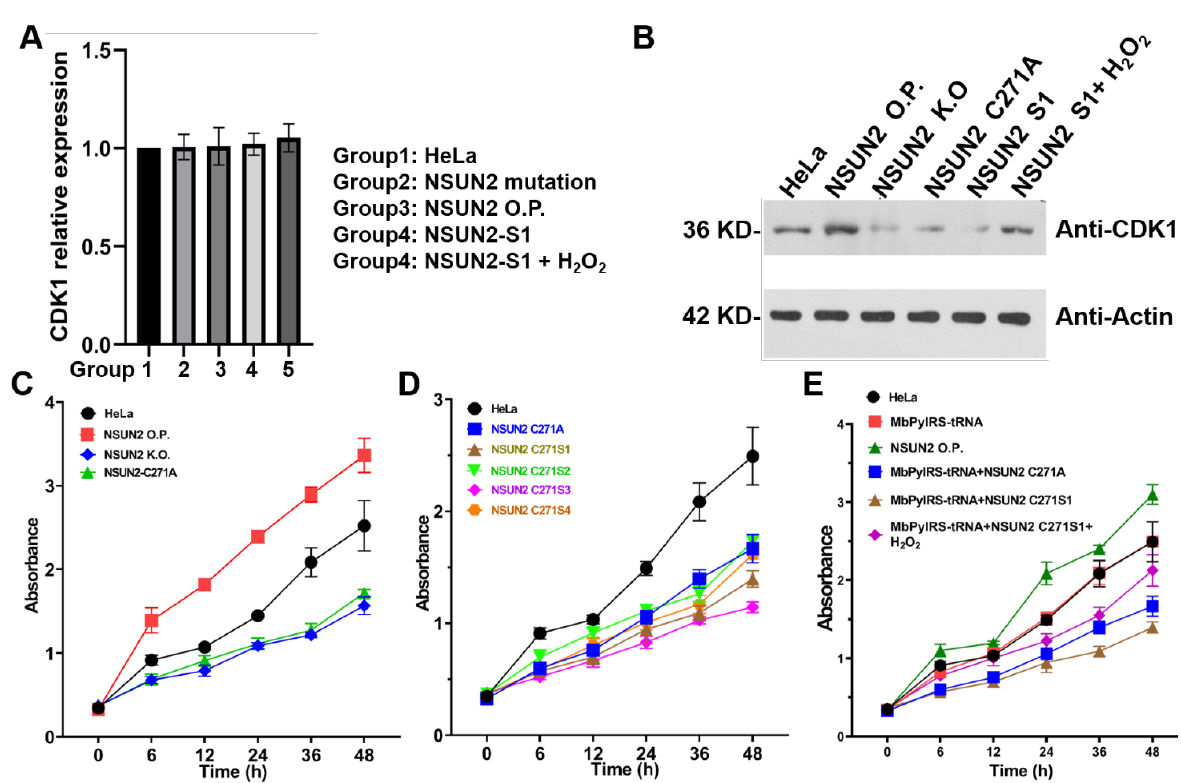
Figure 4. Investigations of NSUN2 mutants towards cells activities. ( A ) Detection of the effect of NSUN2 overexpression, knockout, and C271 mutated to S1 and C271S1 restored to natural lysine on downstream gene CDK1 in HeLa cells via RT-PCR agarose gel electrophoresis. The experimental results show that NSUN2 has no significant effect on the transcription level of CDK1 . ( B ) Detection of the effect of NSUN2 overexpression, knockout, C271 mutated to S1 and C271S1 restored to natural lysine on downstream gene CDK1 in HeLa cells via Western blotting assays. ( C ) The effect of NSUN2 C271A mutation and C271 mutated with S1–S4 on cell proliferation activities, CCK8 was used to detect cell proliferation. The mutation of C271 site significantly inhibited the activity of NSUN2 , and NSUN2 C271 mutated with S3 (pink color) displayed the highest inhibition activity. ( D ) The effect of NSUN2 overexpression, knockout, and active site mutation (C271A) in HeLa cells on cell proliferation. It was noted that the mutation of C271 site significantly inhibited the activity of NSUN2 . ( E ) C271 mutation or replaced by S1 in NSUN2 significantly inhibited HeLa cell proliferation ability. However, the proliferation ability was partly rescued when S1 was transformed into nature lysine by use of H 2 O 2 . MyPylRS - tRNA and NSUN2 overexpression system were transfected into HeLa cells as